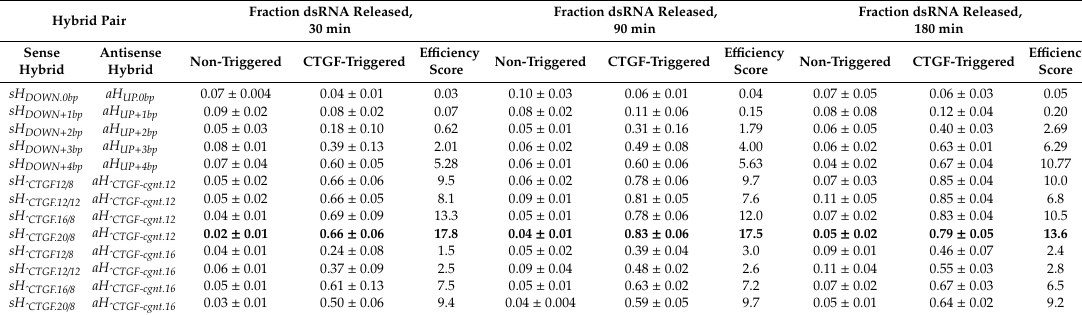
Table 1. Summary of observed dsRNA release from connective tissue growth factor (CTGF) trigger-inducible hybrid pairs. The average fraction of dsRNA release is reported in the presence and absence of CTGF trigger, at each of three time intervals examined. An e ffi ciency score metric is determined for each hybrid pair at a given time point, with a larger score indicating better e ffi ciency of conditional dsRNA release. The e ffi cacy score takes into account both the fraction of dsRNA released and the signal-to-noise ratio. It is calculated as (fraction of triggered release) * (fraction triggered release / fraction non-triggered release). The hybrid pairing that yields greatest e ffi ciency score at each of the three time intervals examined is